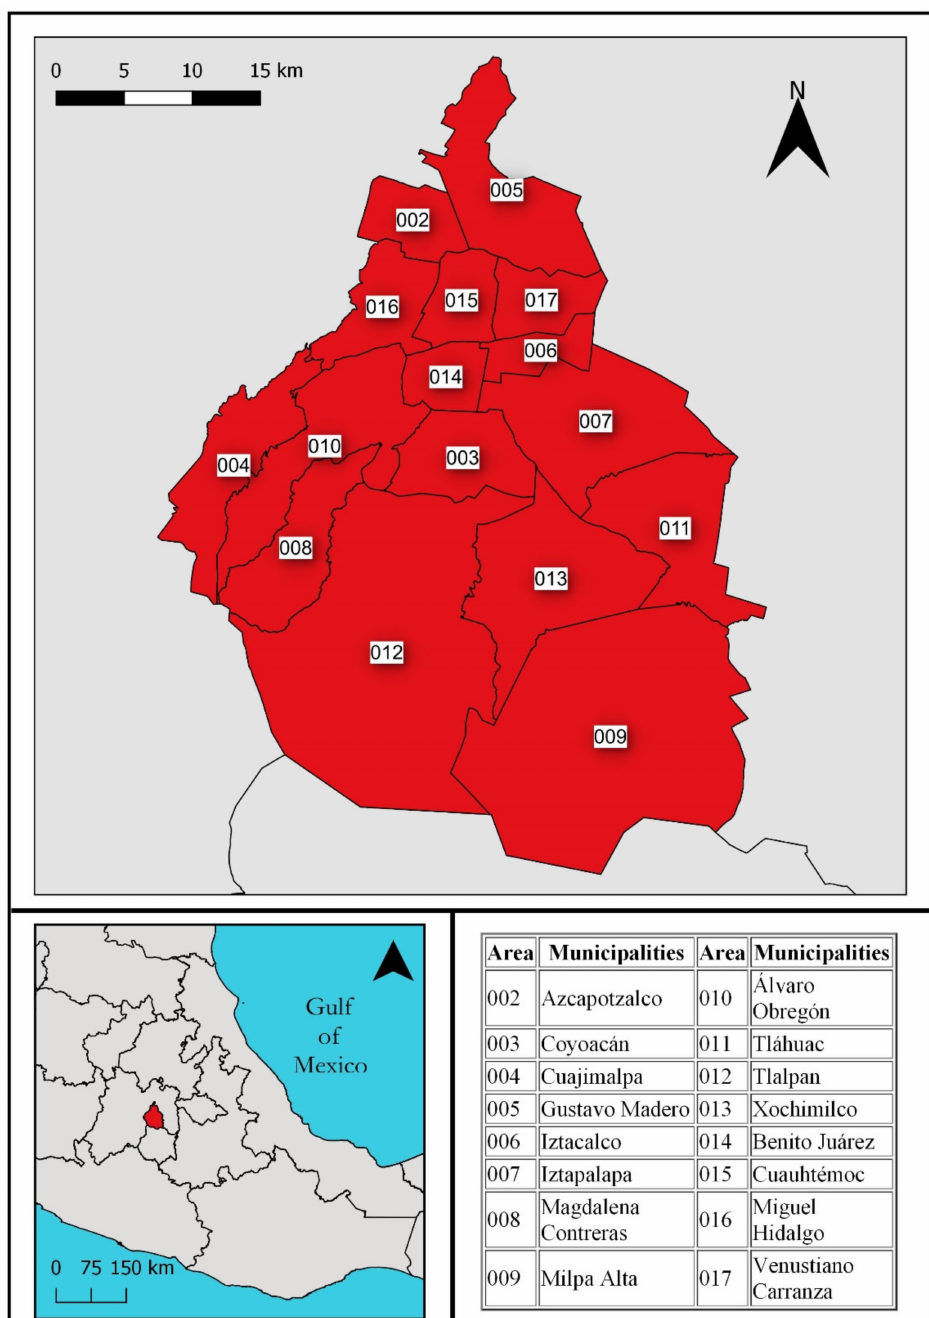
Figure 1. Municipalities of Mexico City. The table on the right shows the city municipalities’ official names and codes [42]. Source: Authors’ own with QGIS